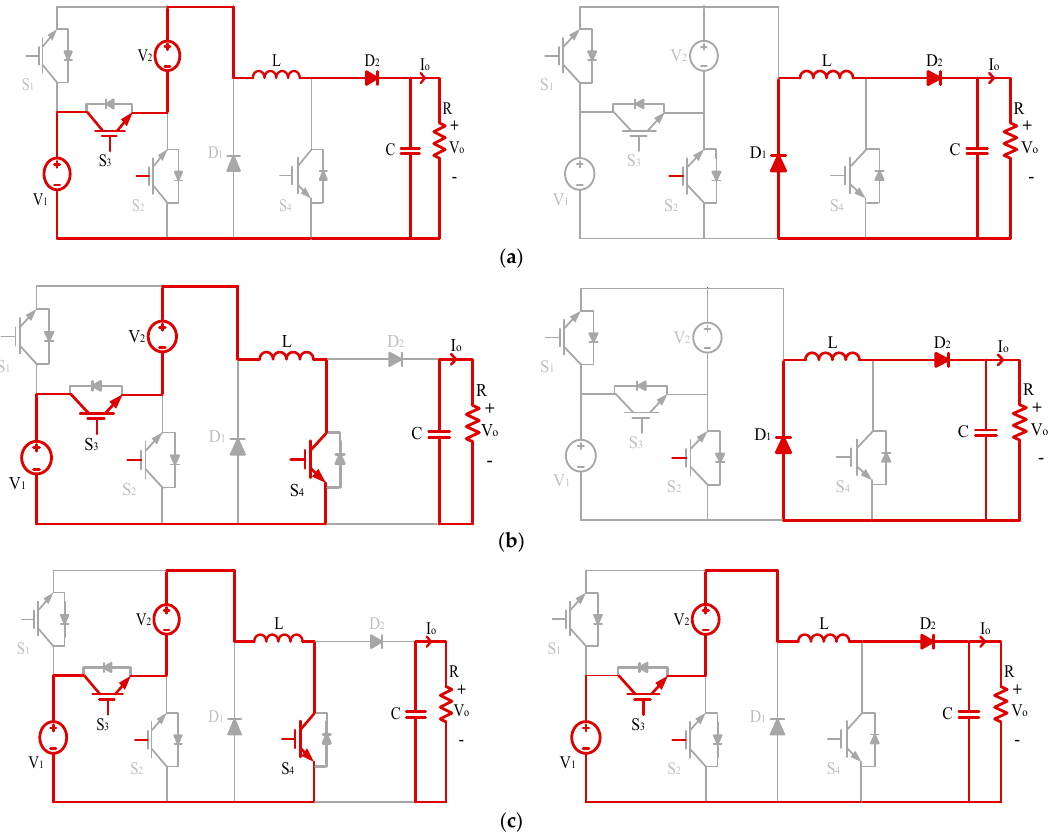
Figure 3. Different type of operation of the MBDC converter: ( a ) buck operation; ( b ) buck-boost operation; and ( c ) boost operation.